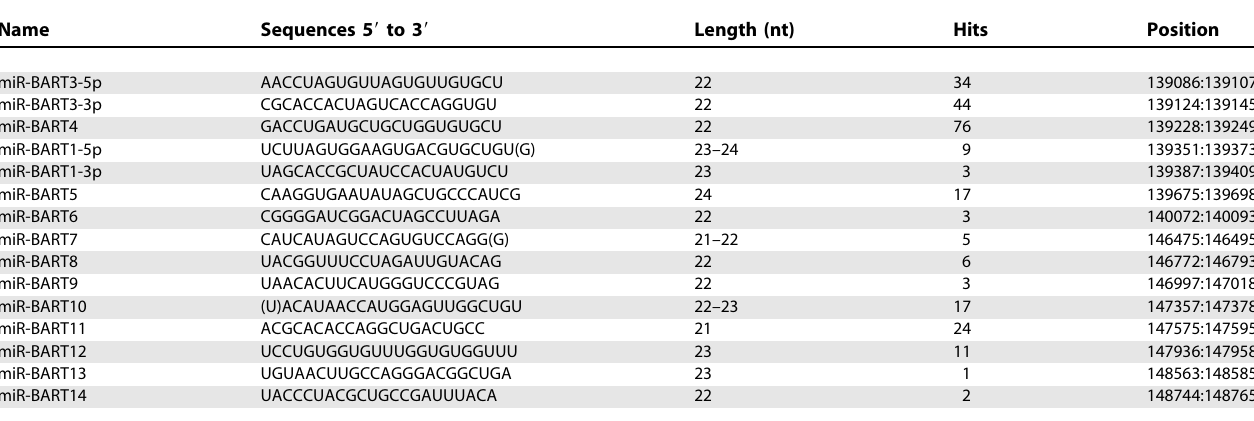
Table 1. Sequence and Genomic Location of EBV miRNAs Cloned from the BC-1 Cell